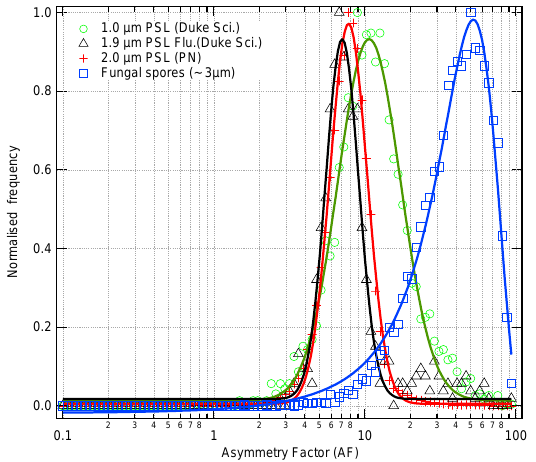
Fig. 2. Background fluorescence intensity change during a one year measurement